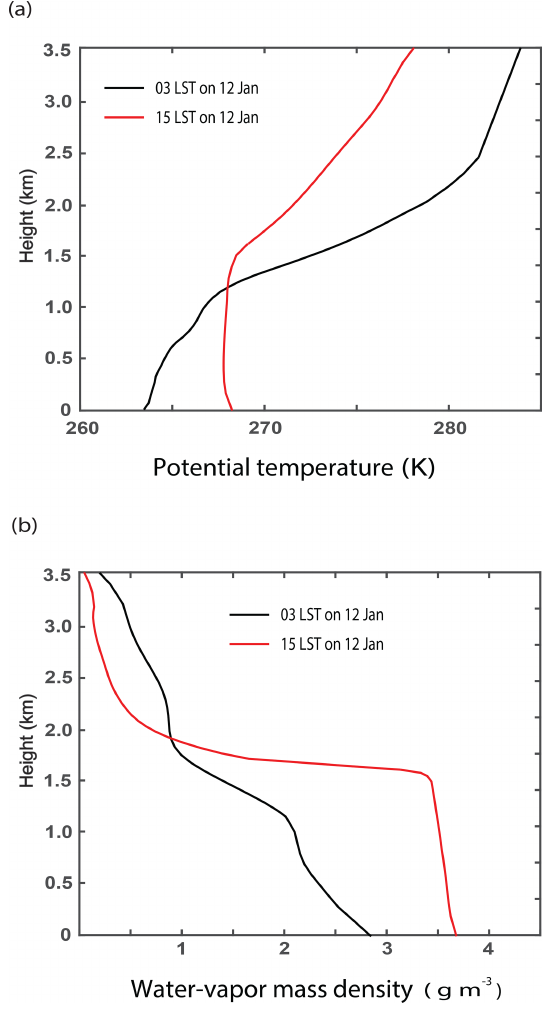
Figure 3. The vertical distributions of the radiosonde-observed (a) potential temperature and (b) water-vapor mass density at 03:00LST and 15:00LST on 12